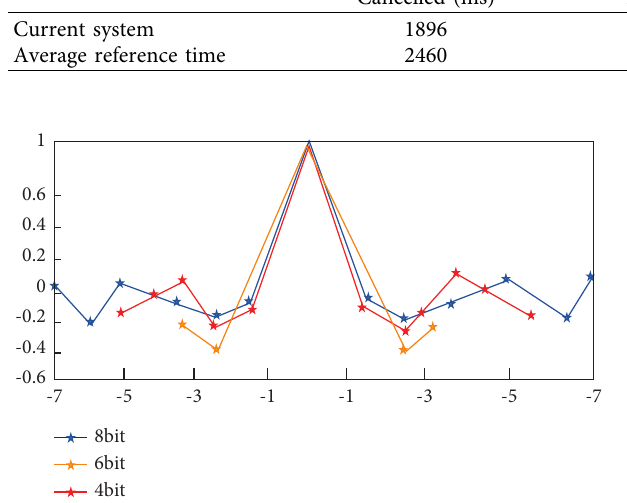
Figure 8: Autocorrelation coefficients of symbols with different